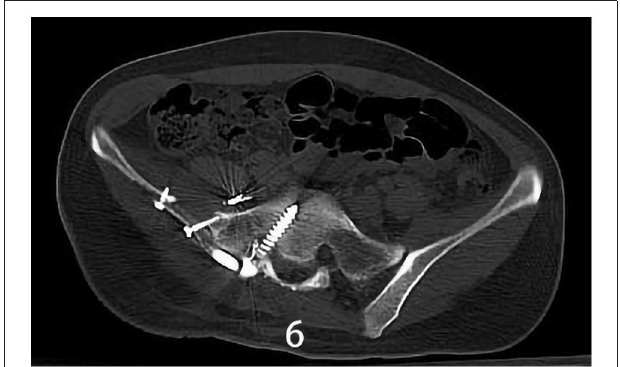
FIGURE 6 | X-ray/CT image of the sacroiliac joint showing synovectomy and arthrodesis followed up 1.5 years after